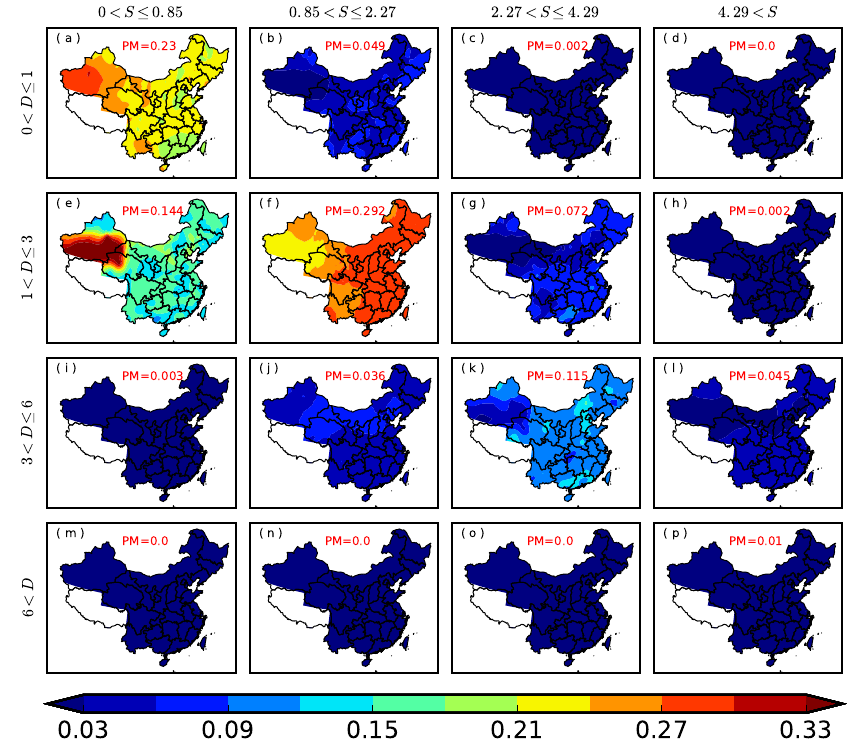
Figure 11. Interval probability based on the entropy method: ( a – p ) represent different drought